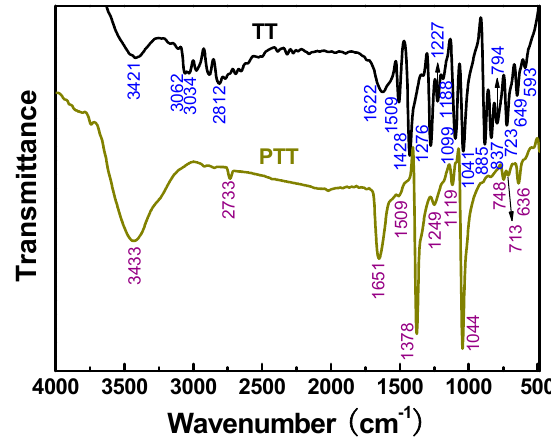
Figure 2. Fourier transform infrared (FT-IR) spectra of the TT monomer and PTT polymer prepared with a CuCl 2 /TT molar ratio of 1.0 and TT concentration of 0.38 mol·L − 1 in DMF at 25 °C for 24 h.